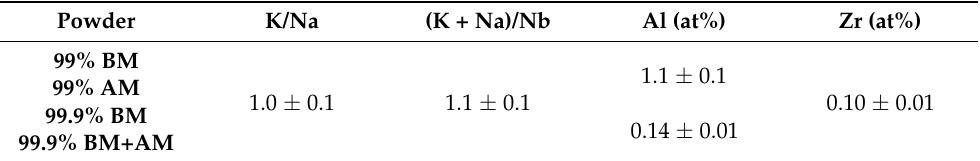
Table 3. Inductively Coupled Plasma (ICP) mass spectroscopy analysis of KNN powders: the alkali ratios and the presence of impurities related with the precursor’s purity grade.